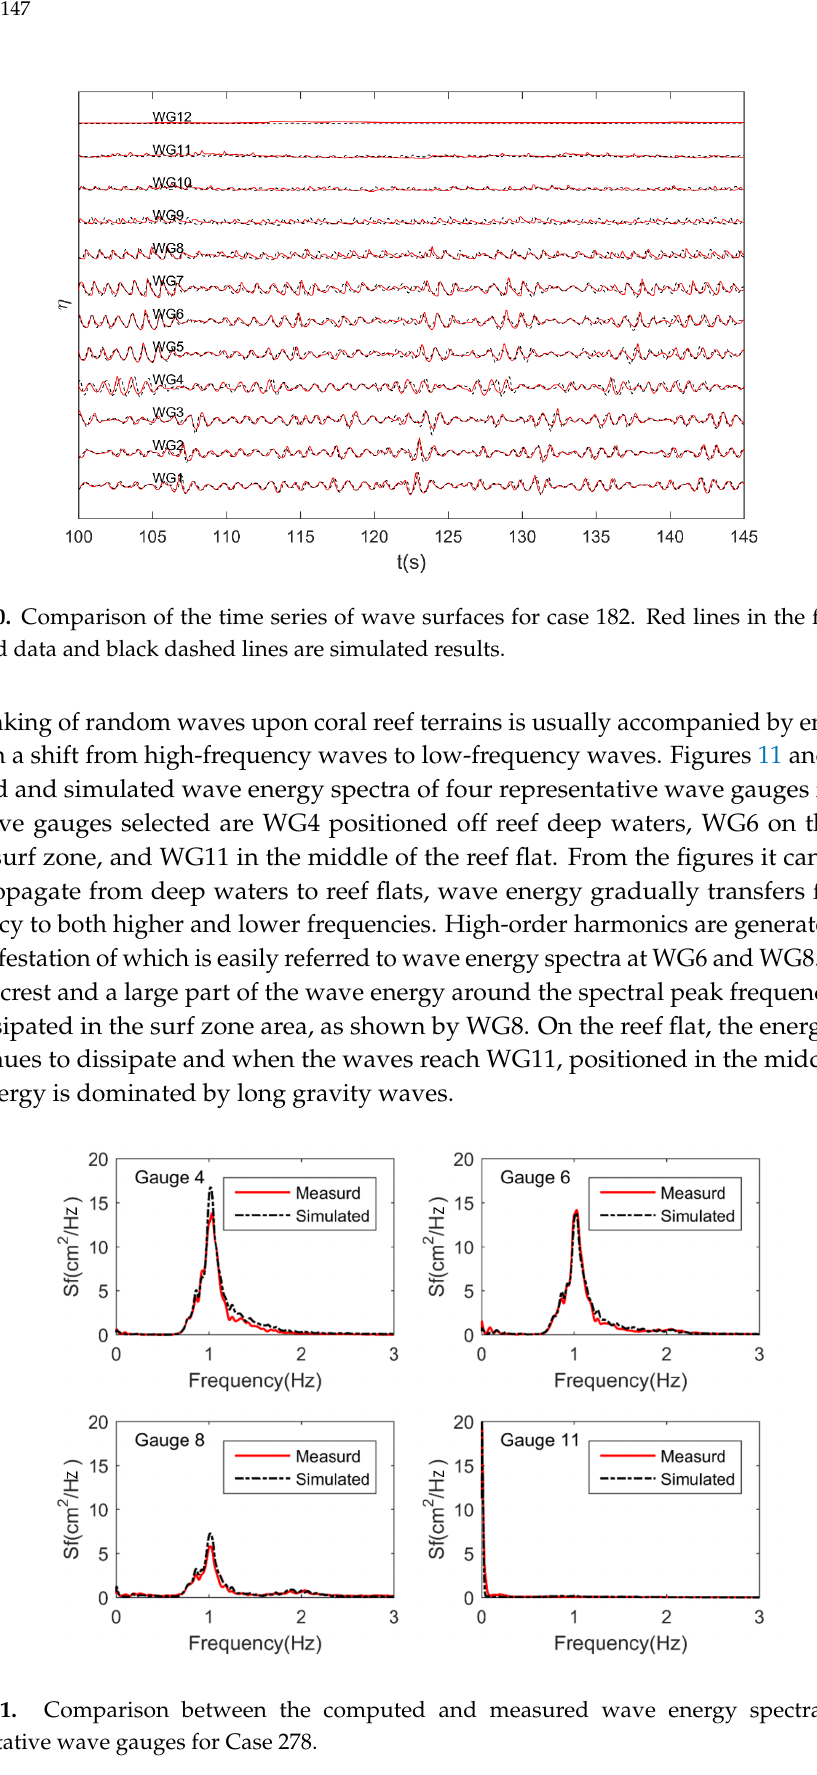
Figure 9. Comparison of the time series of wave surfaces for case 278. Red lines in the figure are measured data and black dashed lines are simulated results.